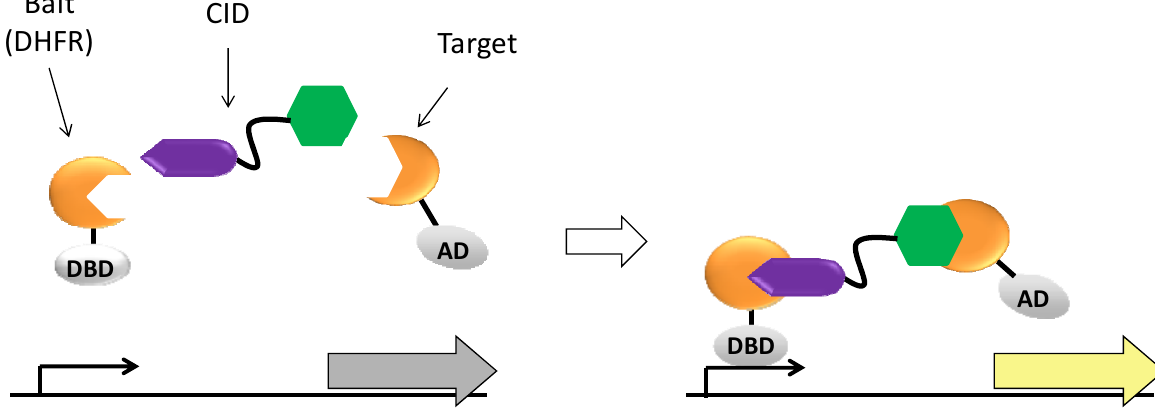
Figure 1. Schematic representation of the Y3H system used in this study showing the ternary complex between the chemical inducer of dimerization (CID) and the two fusion proteins containing the activation and DNA-binding domains of the transcription factor (AD and DBD, respectively). The CID consists of: (i) methotrexate (shown in purple), which binds to the dihydrofolate reductase DHFR-DBD fusion protein; (ii) a flexible linker unit (black line) and (iii) the bioactive molecule of interest (blue hexagon), which binds to the target protein-AD fusion. Successful formation of the ternary complex results in expression of the reporter genes (e.g., LEU2 ) that enables the yeast cell to grow in the absence of the amino